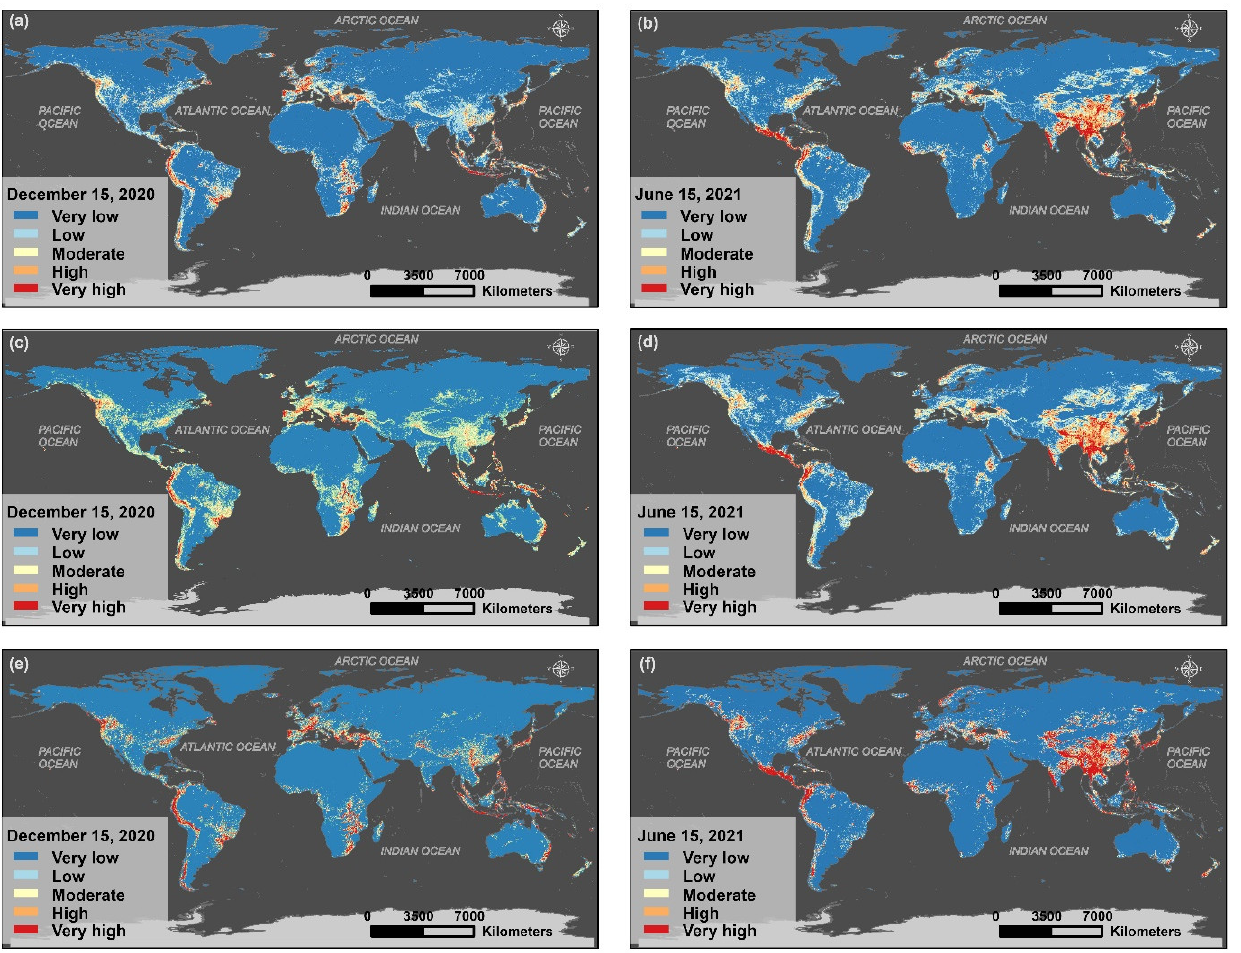
Figure 5. Dynamic LSM results of RF, ET, and LGB on the two example dates. Note: ( a , b ) are the mapping results of the RF model. ( c , d ) are the results of the ET model. ( e , f ) are the results of the LGB model.